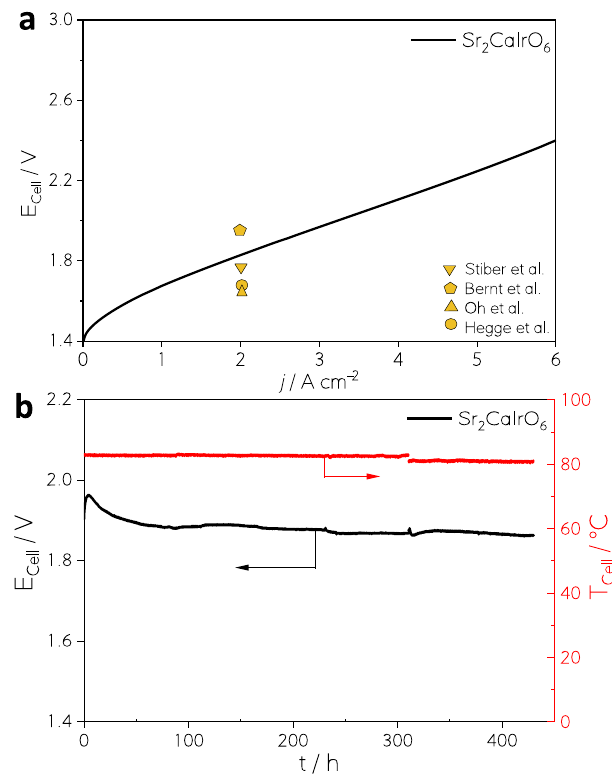
Fig. 5 | Assessment of OER performance during PEMWE. PEMWE measurements with the Sr 2 CaIrO 6 anode (0.4 mg Ir cm − 2 ) and Pt/C (commercial) cathode(0.4 mg Pt cm − 2 ): (a) Cell potential (E cell ) with respect to the current density ( j ) recorded gal- vanostatically up to 6Acm − 2 (overload) according to the JRC EU-harmonized procedure 58 ; a dwell and consecutive recording period of 10s was used for each current step. Reference performance values reached by Stiber et al. 43 Oh et al. 44 , Berntetal. 41 andHeggeetal. 45 ,usingNa fi onN212basedPEMWECCMsareincluded. Note that 41,43,44 use higher Ir loadings. b E cell and cell temperature ( T cell ) evolution overtime( t )(450h)ataconstant2Acm − 2 (nominalload).Themeasurementswere carried out at 80°C and ambient